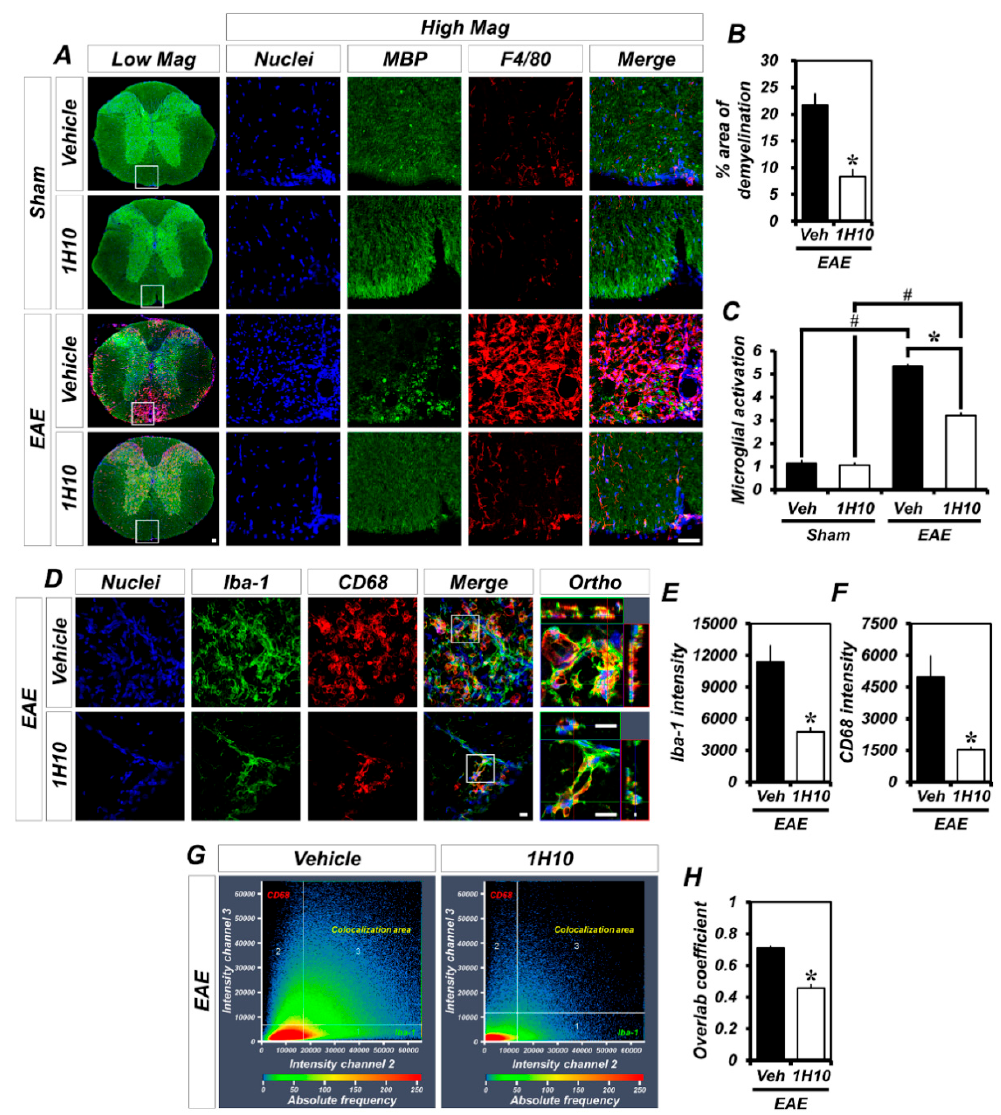
Figure 3. EAE-induced demyelination and microglia/macrophage activation are reduced by treatment with 1H10. ( A ) Representative microglia/macrophage activation in the spinal cord of sham-operated and MOG 35-55 -immunized mice (either vehicle or 1H10) at day 21 as shown by immunofluorescence for F4/80 (red). Demyelinated area shown by reduced myelin basic protein (MBP) staining (green). Nuclei stained with 4 ′ ,6-diamidino-2-phenylindole (DAPI) (blue). Scale bar, 50 μ m. ( B , C ) Bar graphs showing the percent areas of demyelination ( B ) and the grades of microglia/macrophage activation ( C ) as determined in the same spinal cord region (mean ± SEM; n = 3–5 per group). * p < 0.05 vs. vehicle-treated EAE mice; # p < 0.05 vs. sham-operated mice ( B ) unpaired Student’s t -test; C : Kruskal-Wallis test followed by Bonferroni post-hoc test: Chi square = 13.613, df = 3, p = 0.003). ( D ) Representative images of ionized calcium binding adaptor molecule 1 (Iba-1, green) and cluster of differentiation 68 (CD68, red) immunopositive cells as merged images for vehicle- and 1H10-treated EAE mice. Nuclei stained with DAPI (blue). Scale bar, 50 μ m. ( E , F ) Quantification of the immunofluorescence intensity of Iba-1 ( E ) and CD68 ( F ) as determined in the same spinal cord region (mean ± SEM; n = 4 per group). * p < 0.05 vs. vehicle-treated EAE mice (unpaired Student’s t -test). ( G ) Colocalization scatterplots of Iba-1 with CD68. ( H ) Quantitative colocalization parameters of Iba-1 with CD68 determined by measuring Mander’s overlap coefficient (mean ± SEM; n = 4 per group). * p < 0.05 vs. vehicle-treated EAE mice (unpaired Student’s t -test).